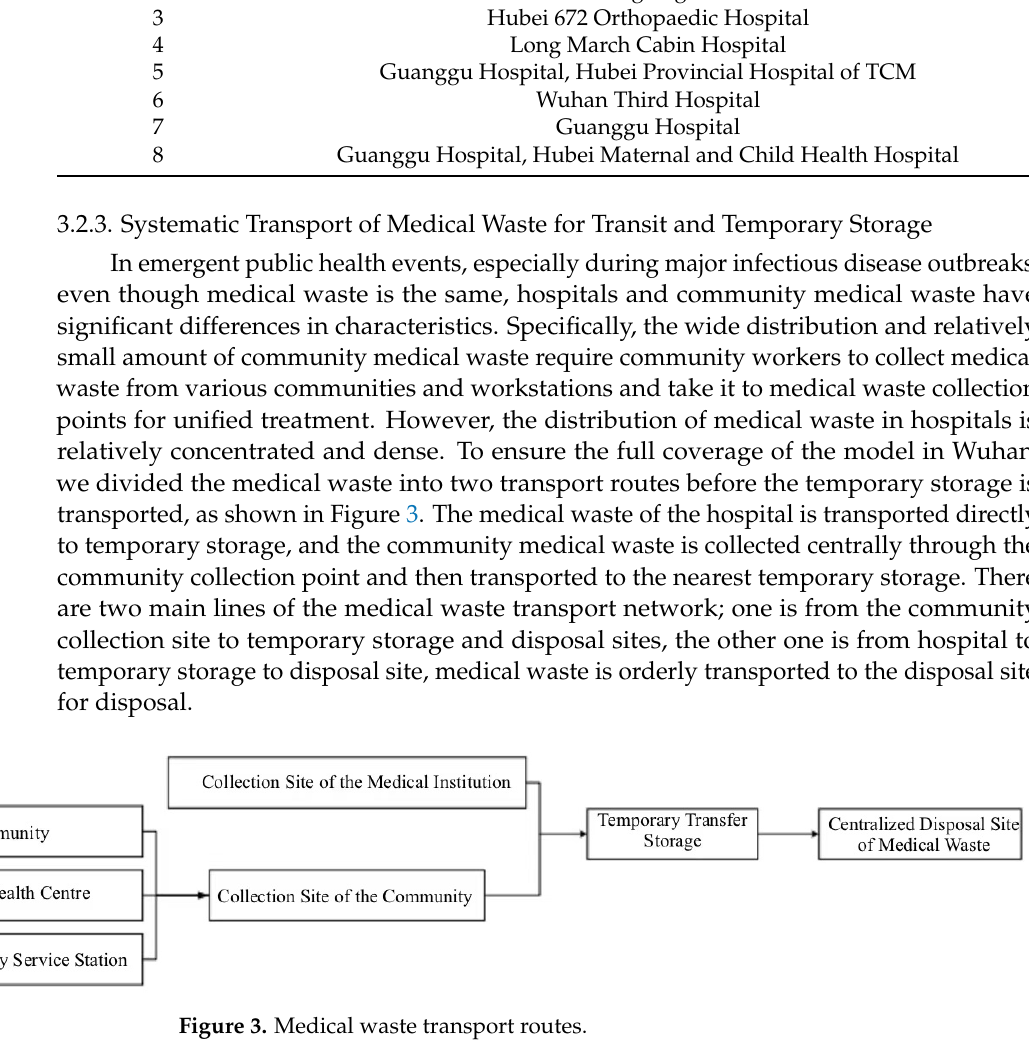
Figure 3. Medical waste transport routes.